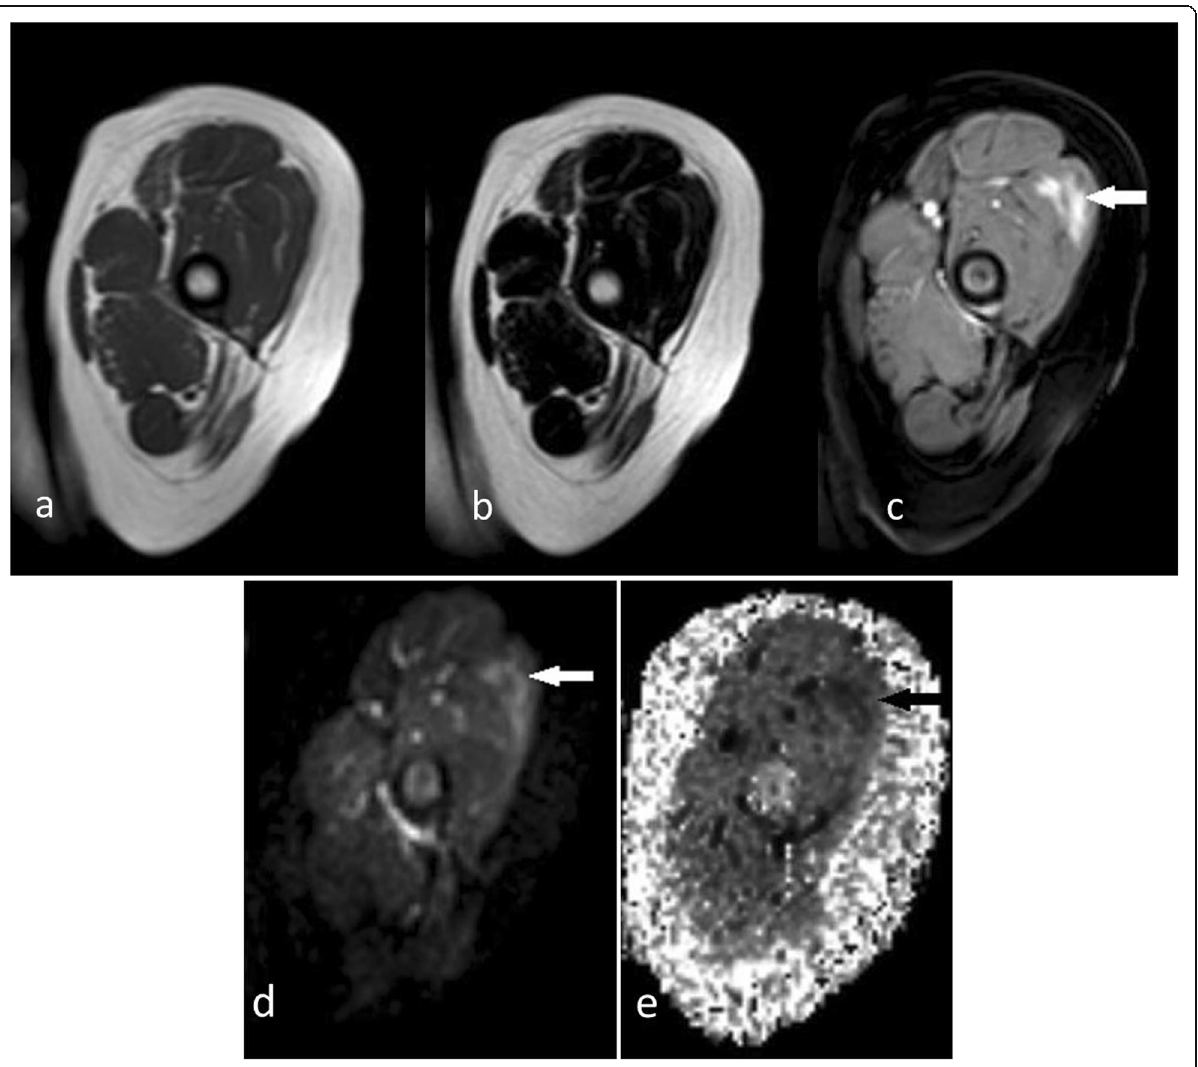
lesion (arrow) at the anterior compartment of the left thigh. Axial DWI ( d ) and ADC ( e ) revealed diffusion restriction in the same